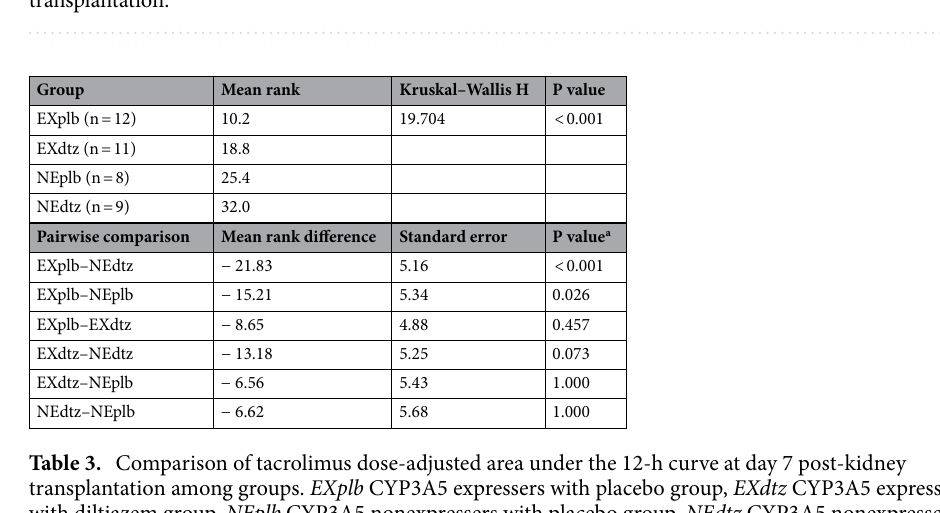
Figure 2. Dose-adjusted area under the 12-h curve of tacrolimus concentration at day 7 post-kidney transplantation.